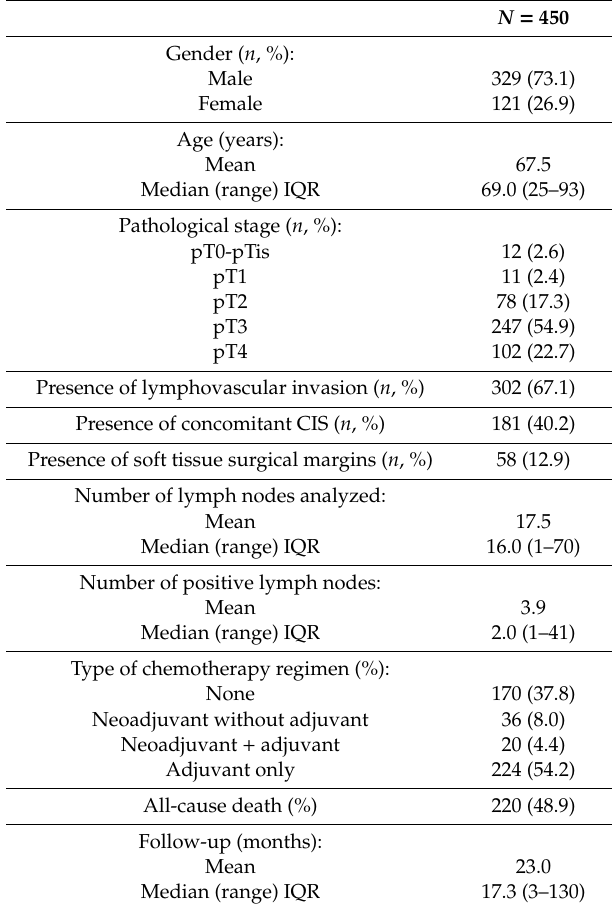
Table 1. Overall cohort clinical and pathological characteristics ( n =